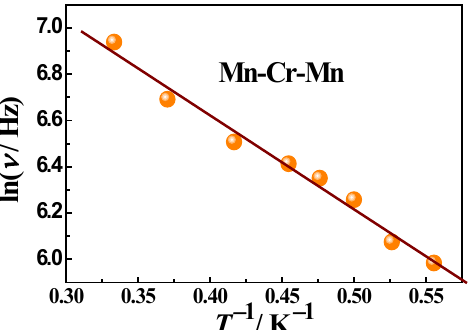
Figure 12. The dependence of ln τ vs. 1/T for 3 in 1500 Oe dc field and its approximation using the Arrhenius formula (solid line). The points were obtained from the frequency dependencies χ ”( ν ) at different temperatures (Figure 11, main text). Approximation parameters: activation energy U eff = 4.1 K, a pre- exponential factor τ 0 = 4.2·10 −6 s.